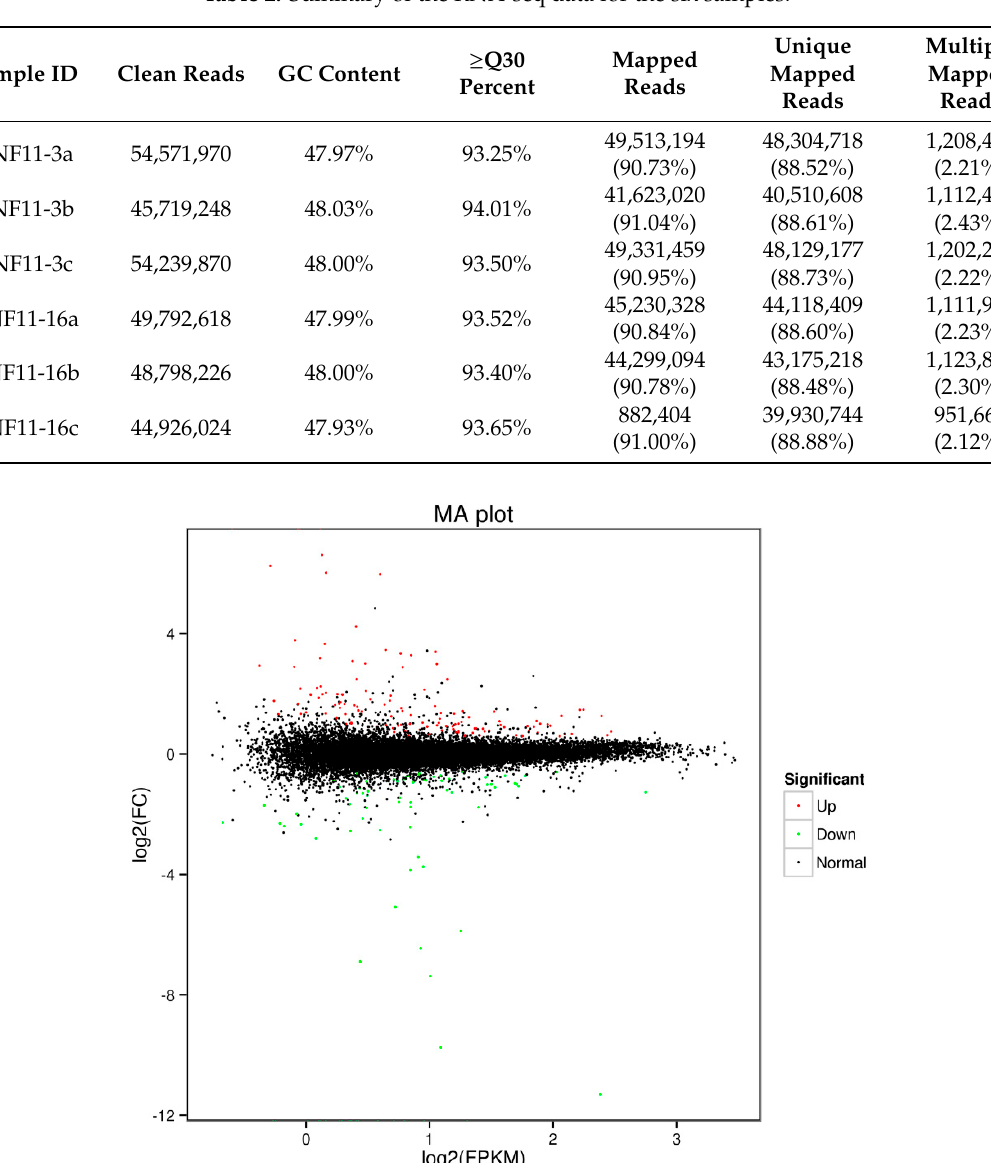
Table 2. Summary of the RNA-seq data for the six samples.